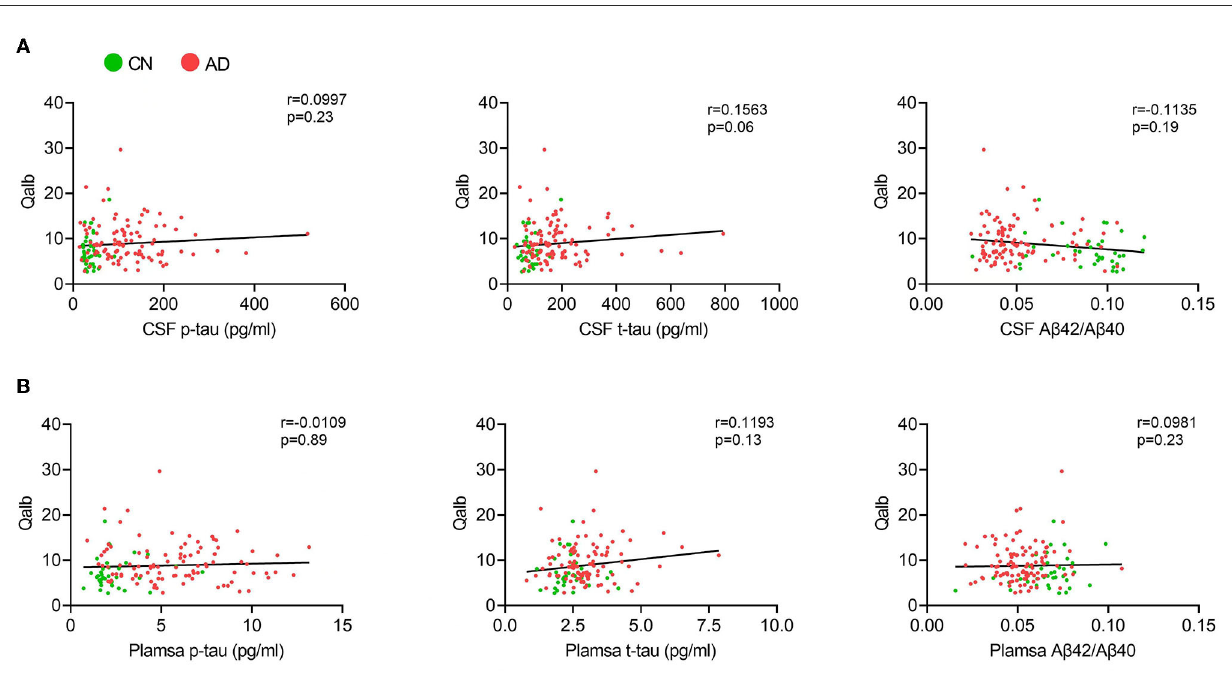
FIGURE3 Correlation between Qalb and fluid biomarkers. (A) Correlation between CSF biomarkers and Qalb. (B) Correlation between plasma biomarkers and Qalb.